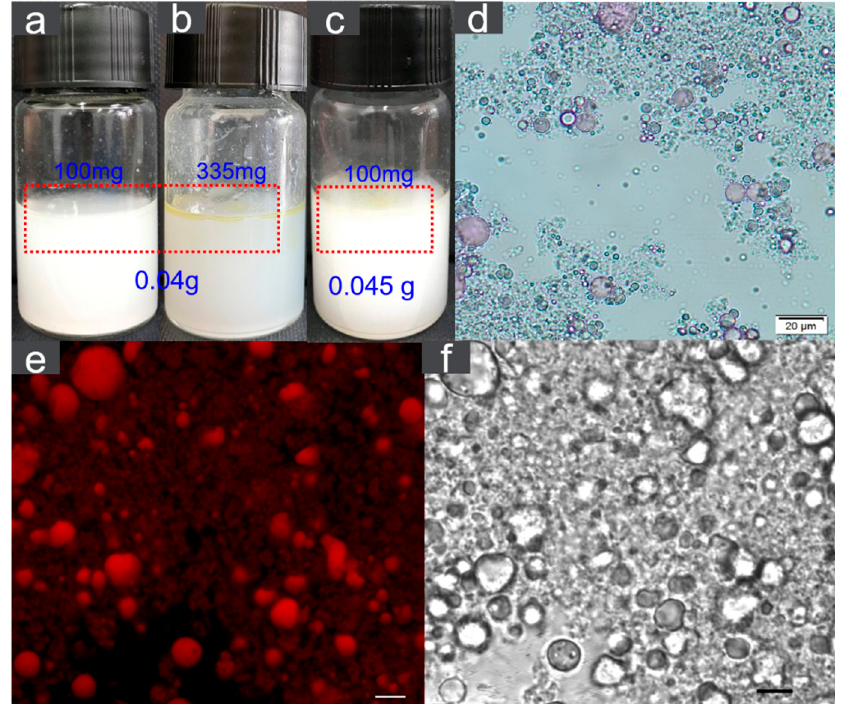
Figure 3. When the addition of SEO was 0.04 g, the oil-carrying performance of organic hollow mesoporous silica formed when the amounts of CTAC were 100 mg ( a ) and 335 mg ( b ), respectively. When the addition of SEO was 0.045, the oil-carrying performance of organic hollow mesoporous silica formed when the amount of CTAC was 100 mg ( c ). Organic hollow mesoporous silica Pickering emulsion with the highest oil loading was characterised by ( d ) microscope image, ( e ) CLSM dark field and ( f ) CLSM bright field, in which the scales of c and d were 10 μ m.